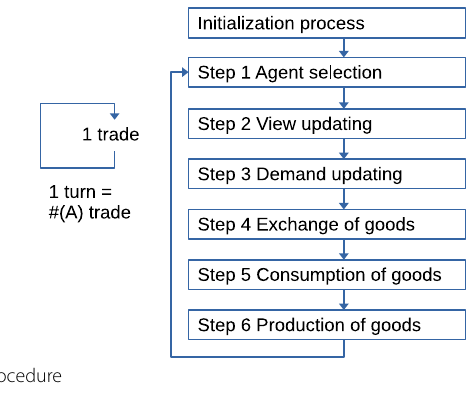
Fig. 1 Flowchart of